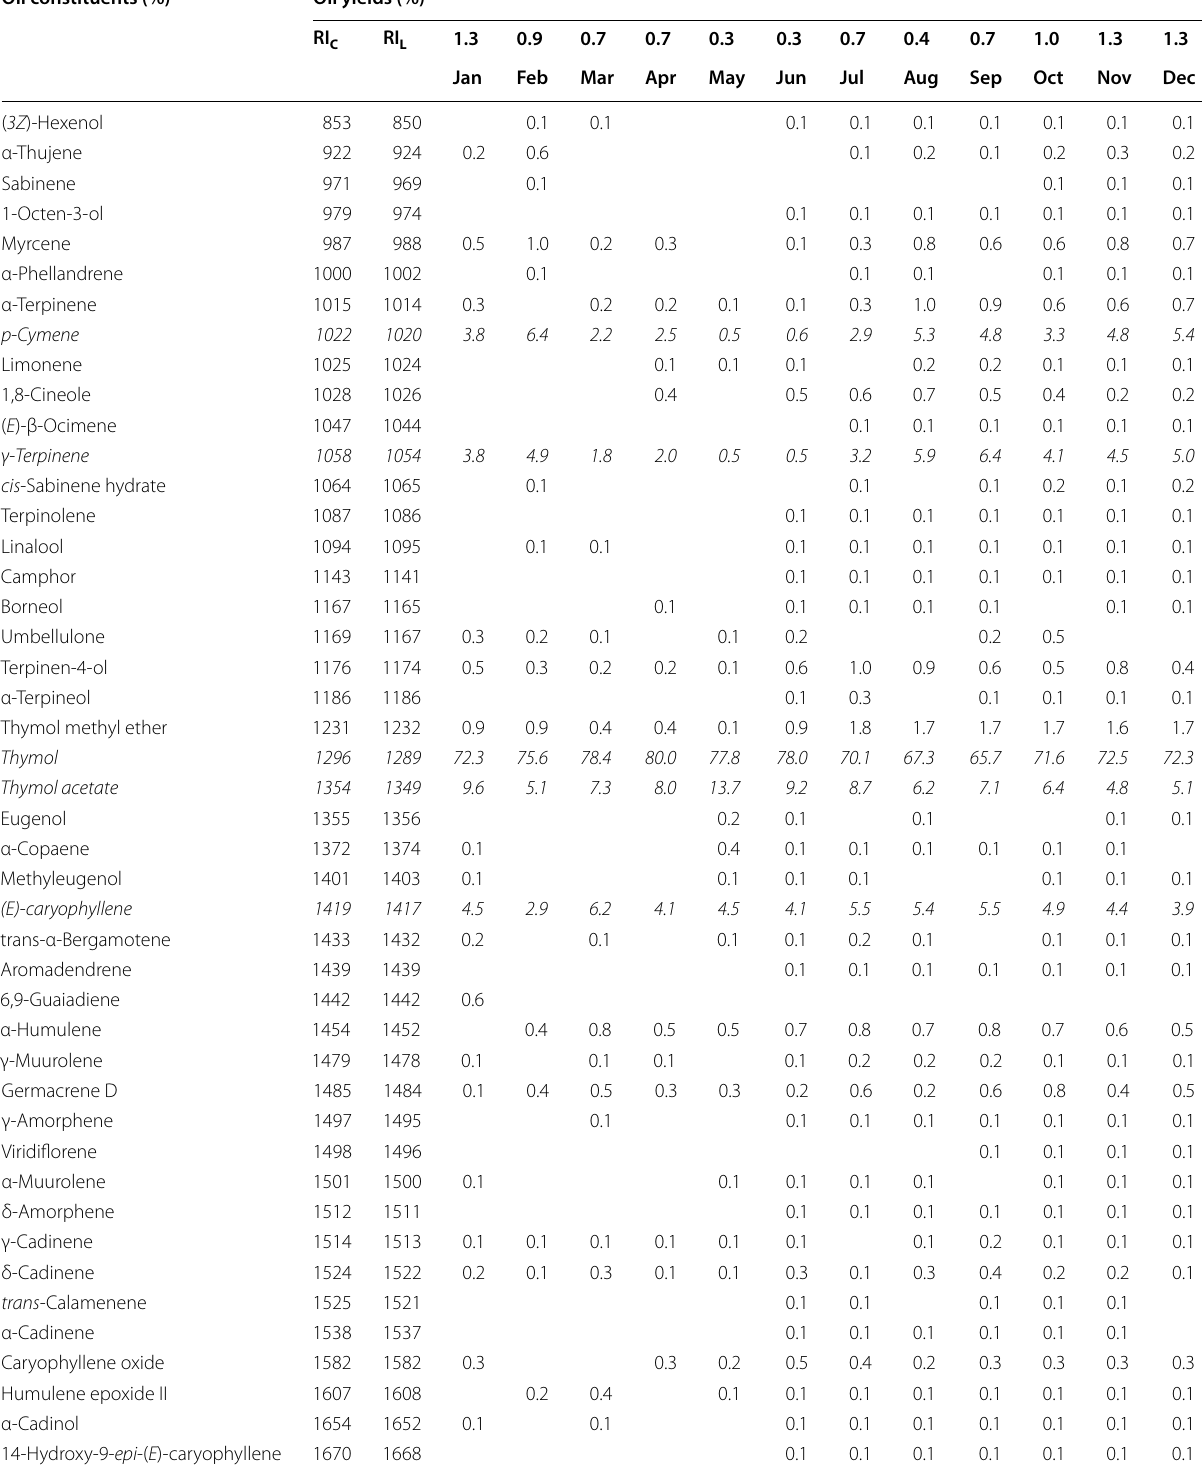
Table 2 Seasonal study of the Lippia thymoides oils during 12 months Oil constituents